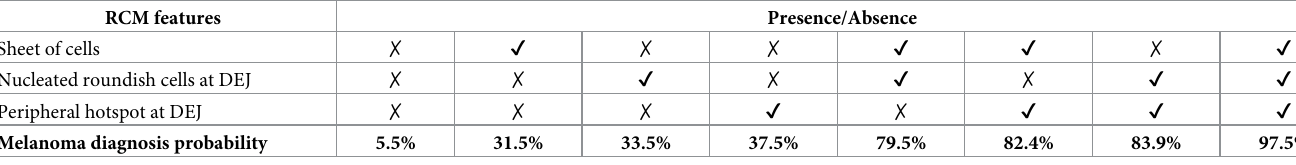
Table 4. Probability of melanoma diagnosis, related to the presence of RCM